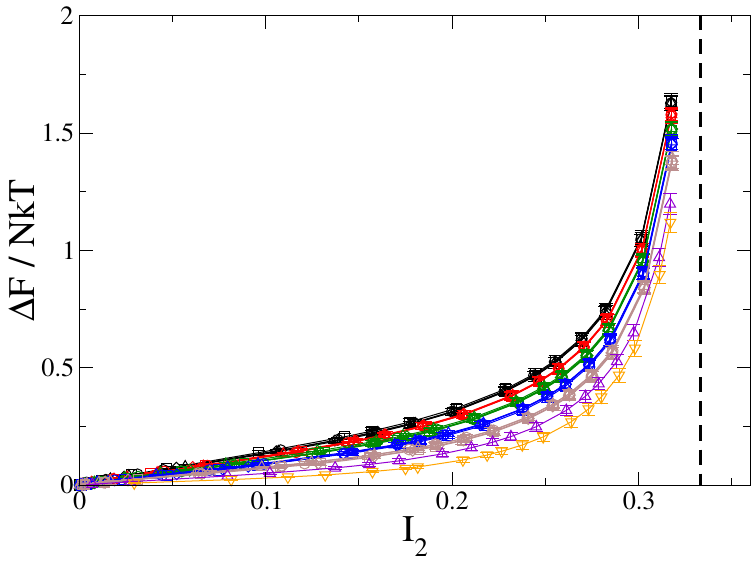
T , for the B ≤ 1 / 3 2